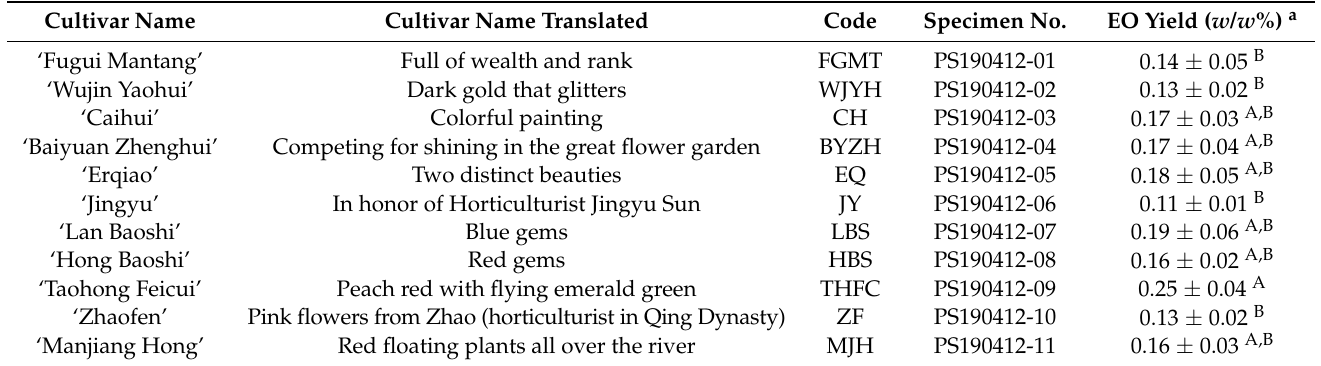
Table 1. Hydro-distillation yields of flower essential oils of the eleven woody peony cultivars ( Paeonia × suffruticosa